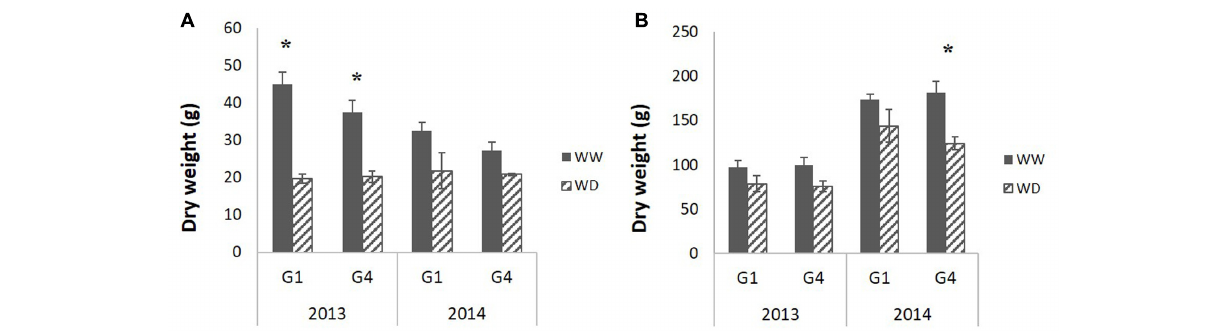
Frontiers in Plant Science |